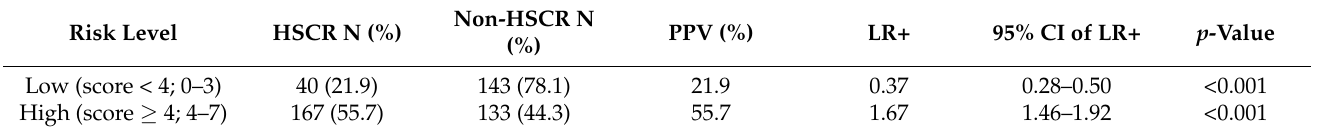
Table 4. Distribution of risk of diagnosis of HSCR, LR+, and 95% CI of LR+.